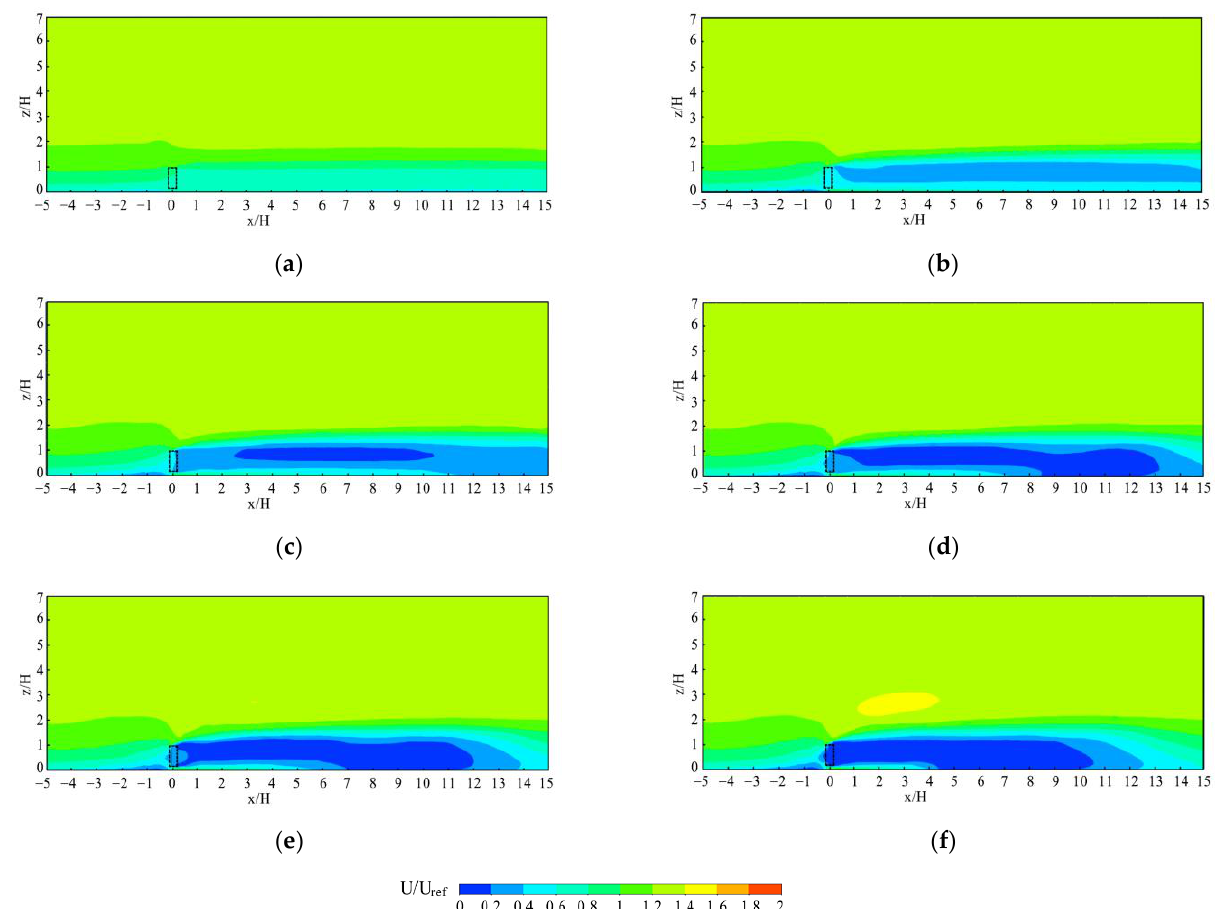
Figure 5. Normalized mean wind speed around the canopy with different porosities in cross section of y/H = 0, ( a ) φ = 85 %, ( b ) φ = 58, ( c ) φ = 46, ( d ) φ = 35, ( e ) φ = 30, ( f ) φ = 18. The dotted line rectangular marks the canopy region occupied by